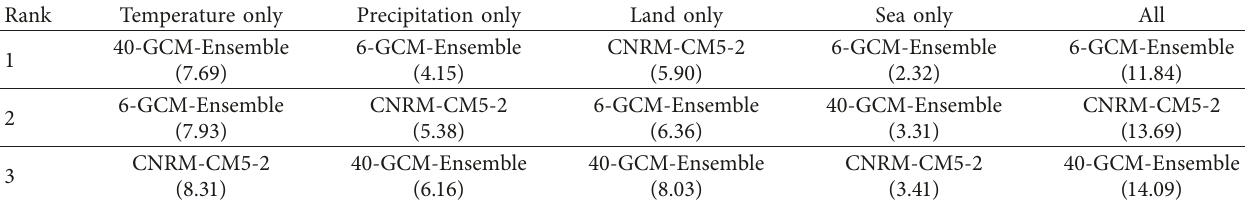
Table 7: Performance ranks of CNRM-CM5-2, 6-GCM-Ensemble, and 40-GCM-Ensemble for different categories, including temperature only, precipitation only, land only, and sea